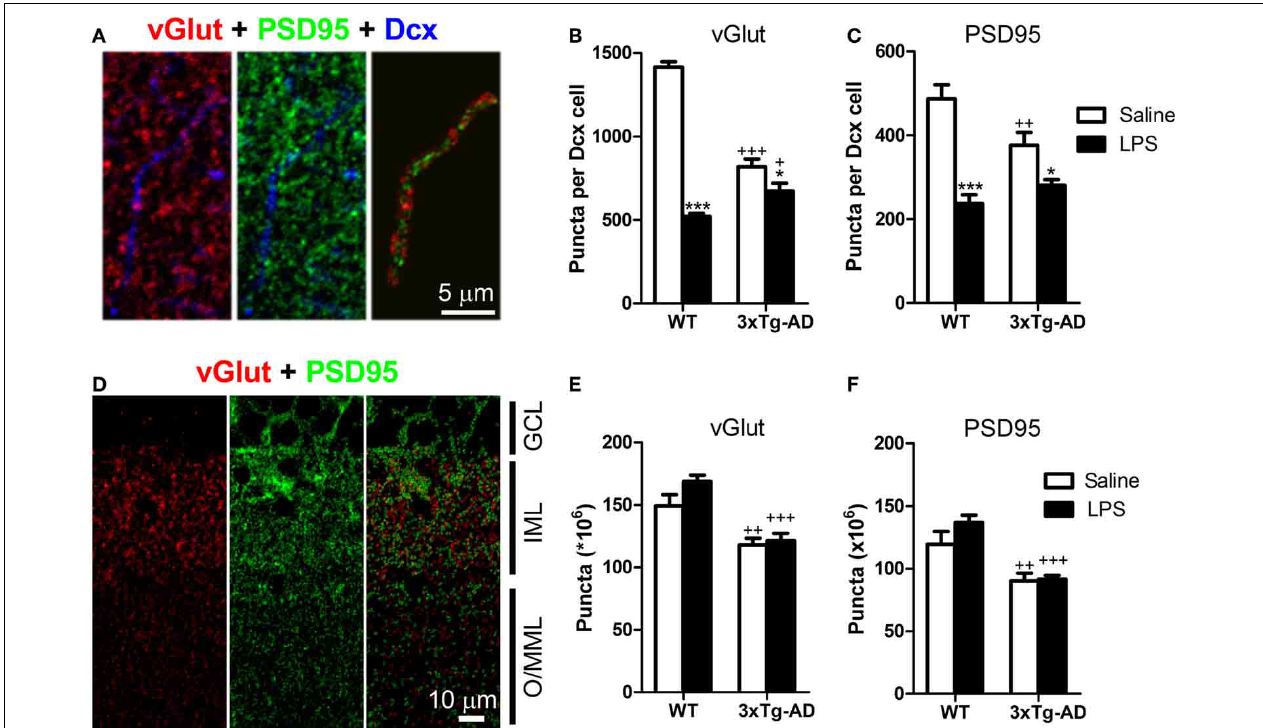
FIGURE 5 | LPS treatment decreases the number of synaptic puncta in the dendrites of doublecortin-positive cells. (A) Confocal microscope image showing a doublecortin (Dcx)-positive dendrite in the outer/mid molecular layer (O/MML) and colocalizing PSD95-positive post-synaptic or juxtaposed vGlut-positive presynaptic puncta. (B,C) 3xTg-AD showed a significant decrease in the number of O/MML vGlut and PSD95-positive puncta per Dcx-positive cell. LPS reduced synaptic puncta in WT and 3xTg-AD Dcx-positive cells. (D) Confocal microscope image showing vGlut